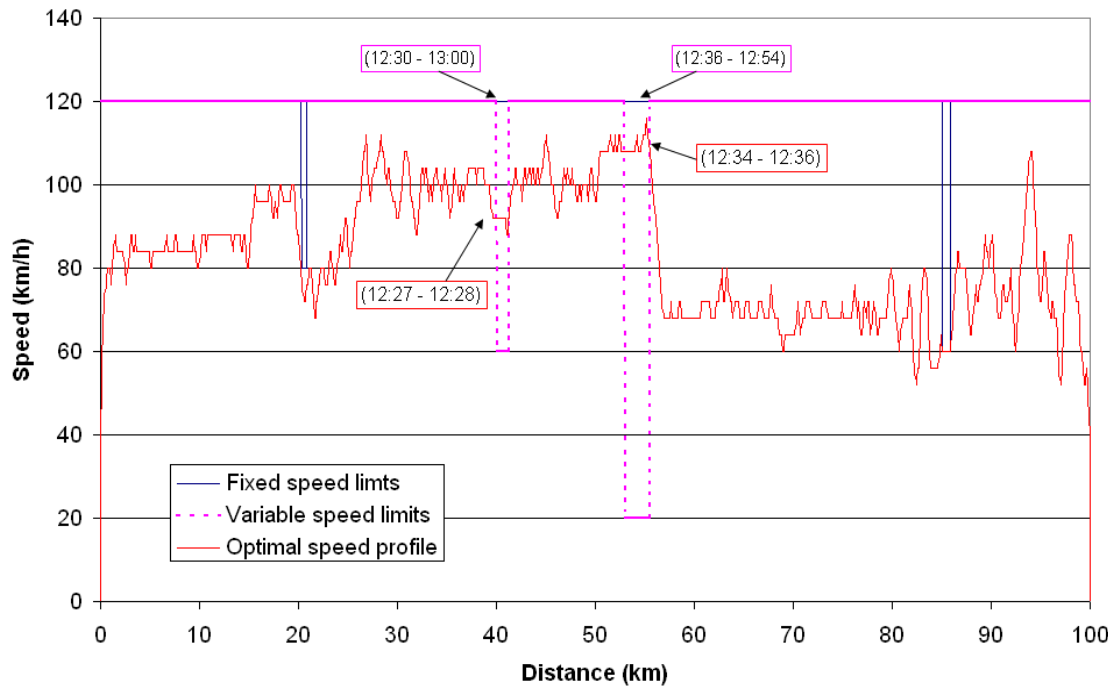
Figure 7. Optimal speed profile (unexpected speed